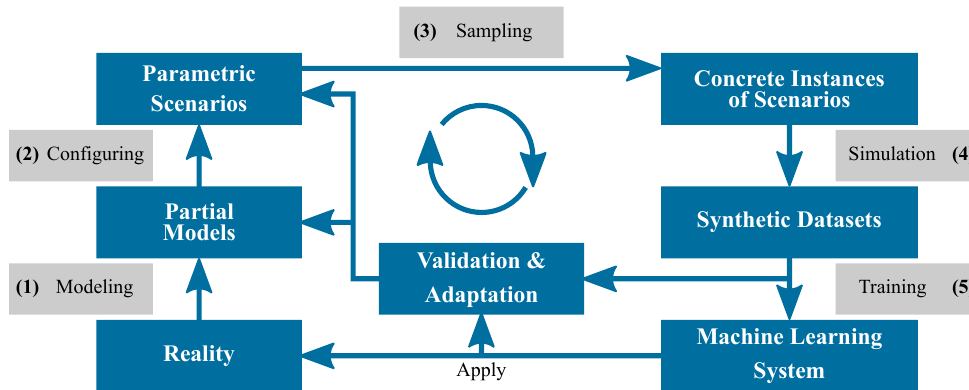
Figure 1. Workflow for synthetic data generation. The process starts by creating partial models of reality by modelling or capturing individual aspects such as geometry or physical properties. The partial models are composed of parametric scenarios by manual configuration or data fitting. The composition is performed in such a way that all aspects of reality relevant to a specific simulation are provided. Setting all parameters to fixed values creates a simulation-ready concrete instance of the scenario. This can be used to generate synthetic data, e.g., images, which are used to train a machine learning system. This cycle is then refined iteratively by adapting parts of the pipeline with help of validation processes to enhance the parametric models and the quality of synthetically generated data. Figure adapted from